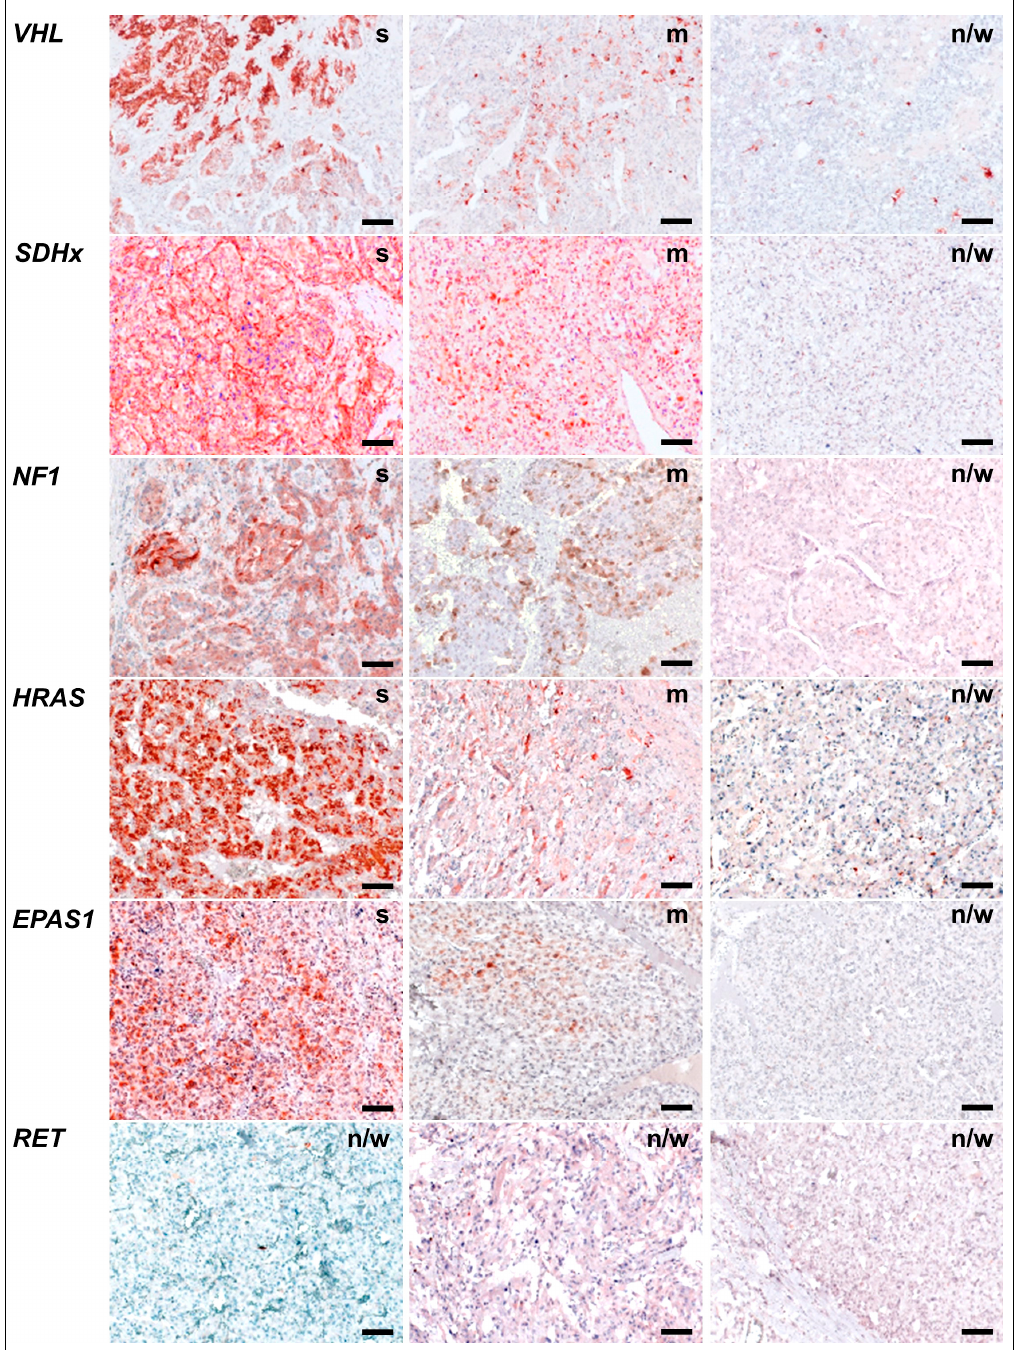
Figure 2. Scoring of COX-2 immunoreactivity in PPGL tissue samples; examples for cases carrying loss-of-function-mutations in VHL , SDHx , or NF1 , or gain-of-function mutations in HRAS , EPAS1 , or RET , (s) strong immunoreactivity, > 50% of tumor cells were stained; (m) moderate immunoreactivity, 20–50% of tumor cells were stained; (n / w) negative or weak, < 20% of tumor cells were stained; scale bars: 0.1 mm.